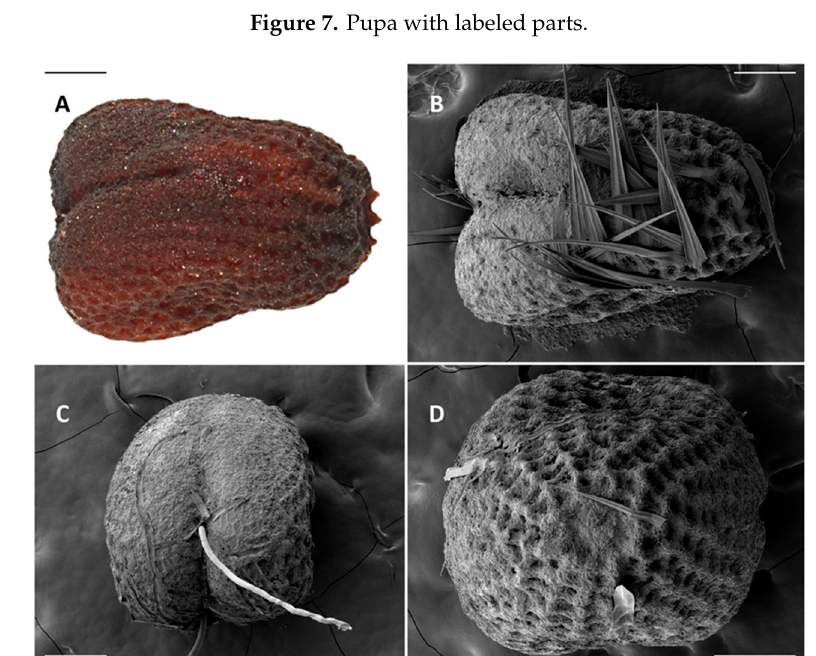
Figure 8. Egg of C. subagronoma ( A ) in color; ( B ) longitudinal groove bisecting the wide end; ( C ) longitudinal groove, top view; ( D ) micropile depression surrounded by blunt points. Measure bar = 0.2 mm.